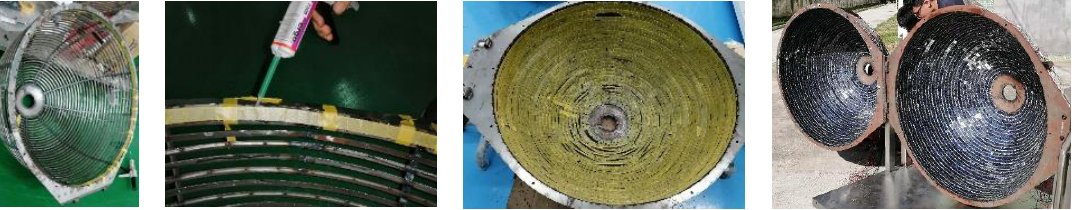
Figure 10. The installation of the photovoltaic cell.